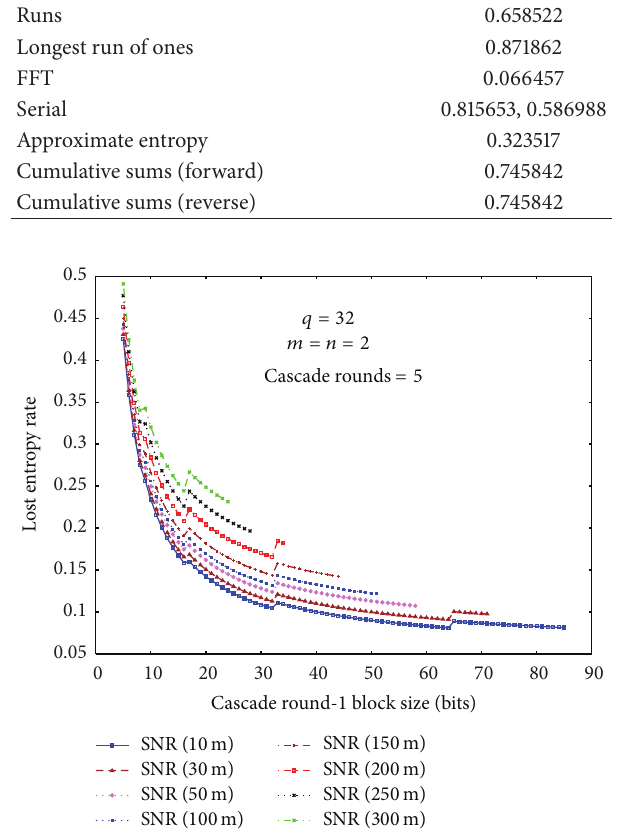
Figure 8: Lost entropy rates under different SNRs and Round-1 cascade blocks.